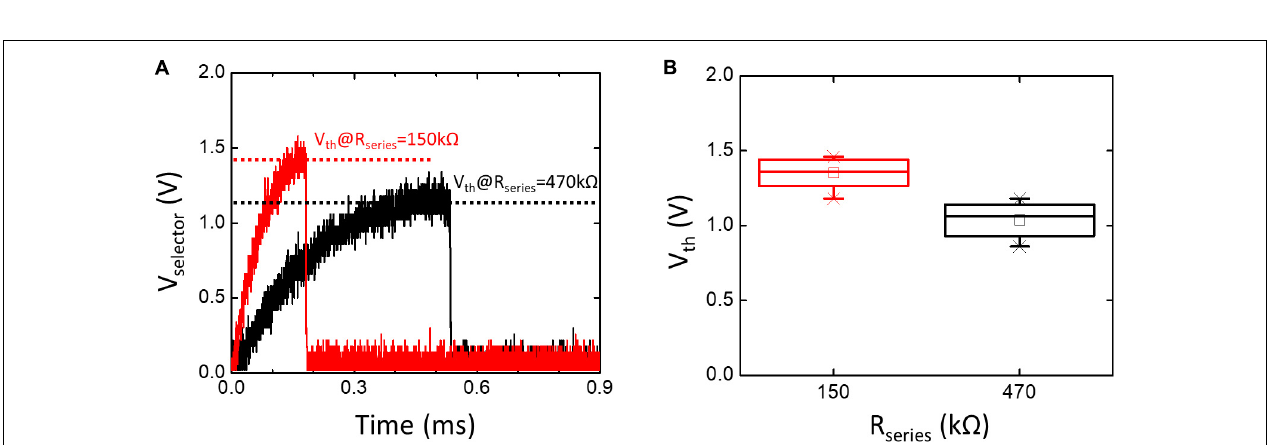
FIGURE 4 | (A) The oscilloscope waveform of V selector when the TS selector is connected with R series of 150 and 470 k (cid:127) and V input = 2 V. Corresponding V th is also indicated. (B) Statistically measured V th increases with decreasing R series . Instead of remaining constant, the history-dependent V th needs to be carefully considered in the TS neuron model.